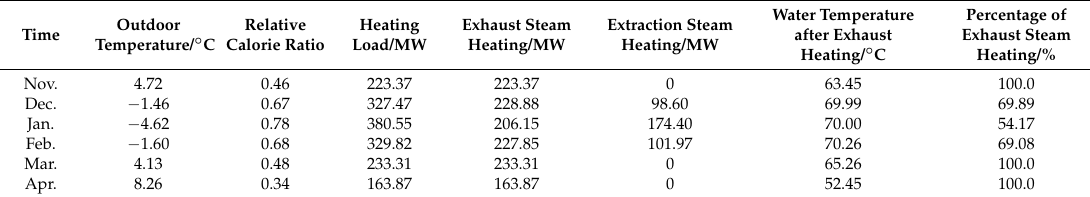
Table 2. Heat load distribution between the two CHP